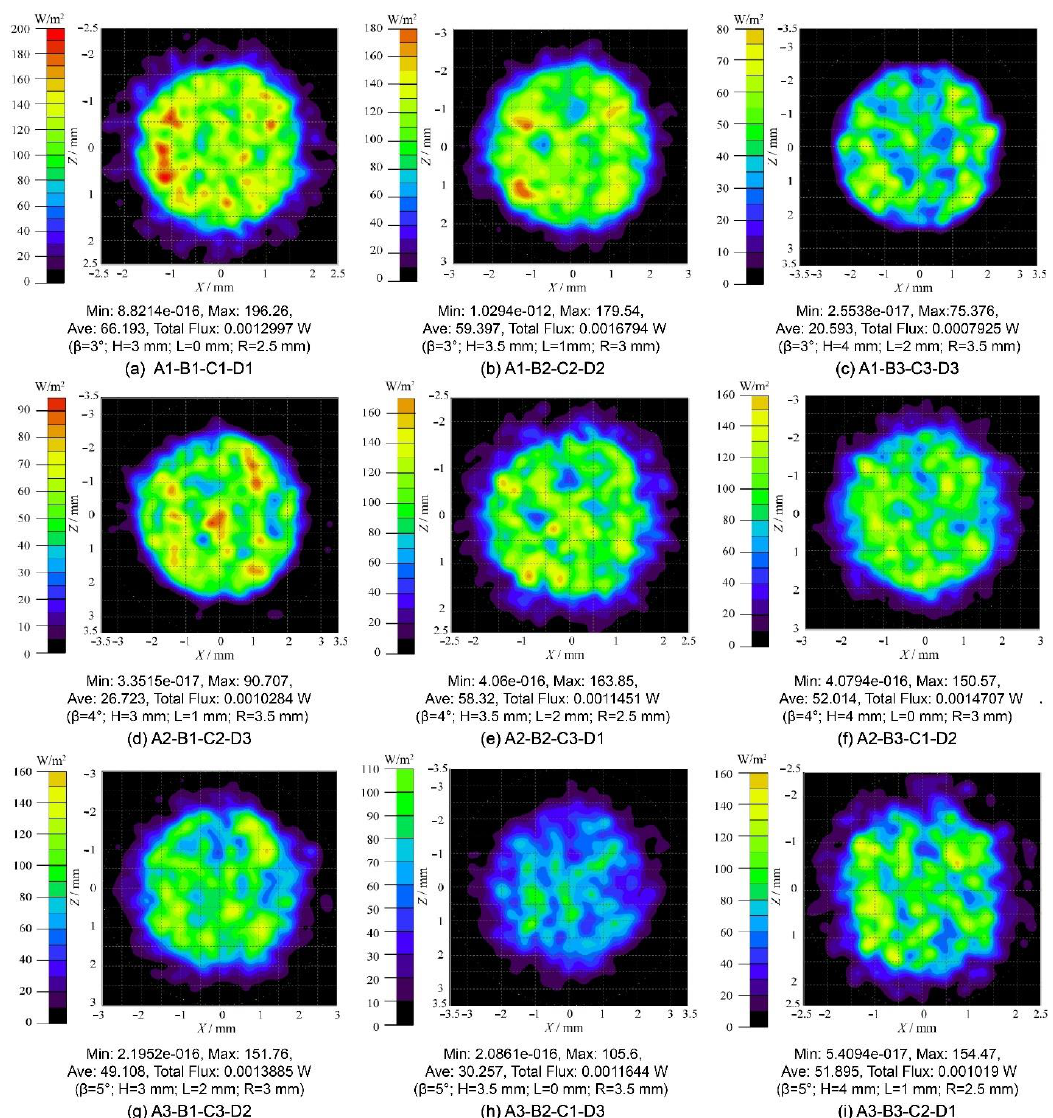
Figure 5. Diagram of the received irradiance distribution for the different parameter combinations of the optical receiver.